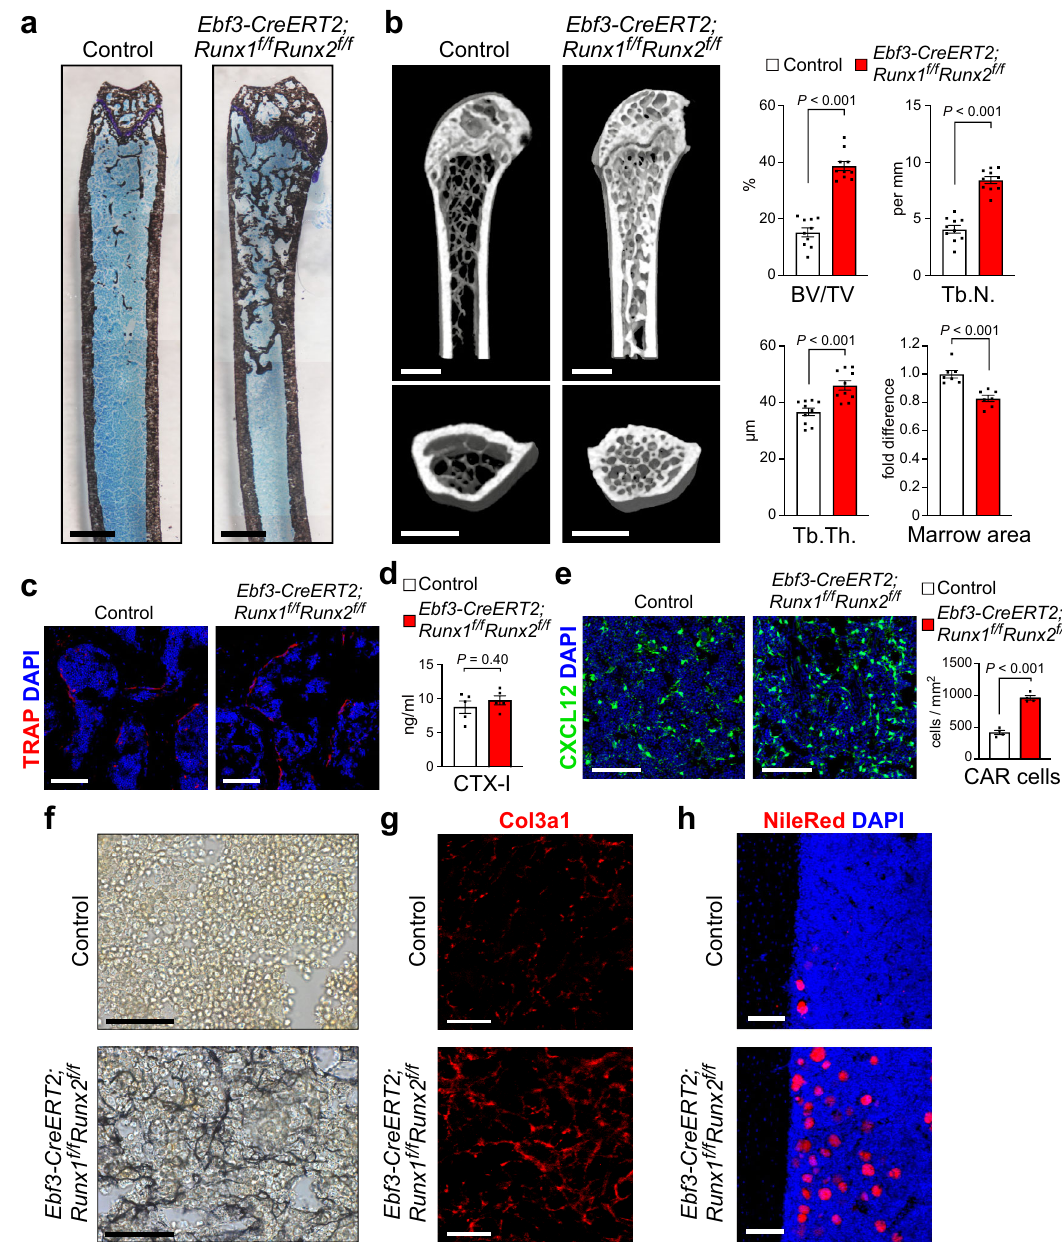
Fig. 4 Increased bone formation and fi brosis in mice lacking Runx1 and Runx2 in CAR cells. a – h Bone marrow ( a – c , e – h ) and serum ( d ) from 20- to 24- week-old tamoxifen-treated control and Ebf3-CreERT2;Runx1 f/f Runx2 f/f ;CXCL12-GFP mice were analyzed. a von Kossa and toluidine blue staining of section from the femur. Bars: 1 mm. b Three-dimensional μ CT image of proximal femurs and analysis of the μ CT image for bone volume per tissue volume (BV/TV) ( n = 10 mice per group), trabecular number (Tb. N) ( n = 10 mice per group), trabecular thickness (Tb. Th) ( n = 10 mice per group), and bone marrow area ( n = 7 mice per group). Bars: 1 mm. c TRAP + osteoclasts in the metaphysis of the femur. Bars: 100 μ m. d Serum CTX-I ( n = 5 mice per group). e Confocal microscopy images showing expression of CXCL12-GFP and the frequencies of CAR cells ( n = 4 mice per group). Bars: 100 μ m. f , g Silver staining ( f ) and immunostaining with antibodies against Col3a1 ( g ) of sections from the femur. Bars: 50 μ m ( f ) and 20 μ m ( g ). h Imaging of femurs showing adipocytes, as assessed by Nile Red staining. Bars: 100 μ m. All error bars represent SD of the mean. Statistical signi fi cances were calculated using the two-tailed unpaired Student ’ s t -test. Source data are provided as a Source Data fi